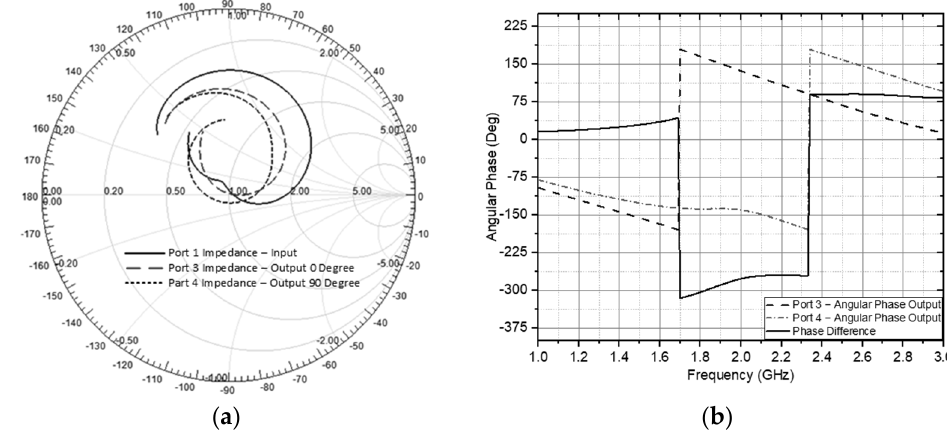
Figure 17. ( a ) Hybrid Coupler circuit impedance ( b ) Hybrid Coupler circuit phase output.